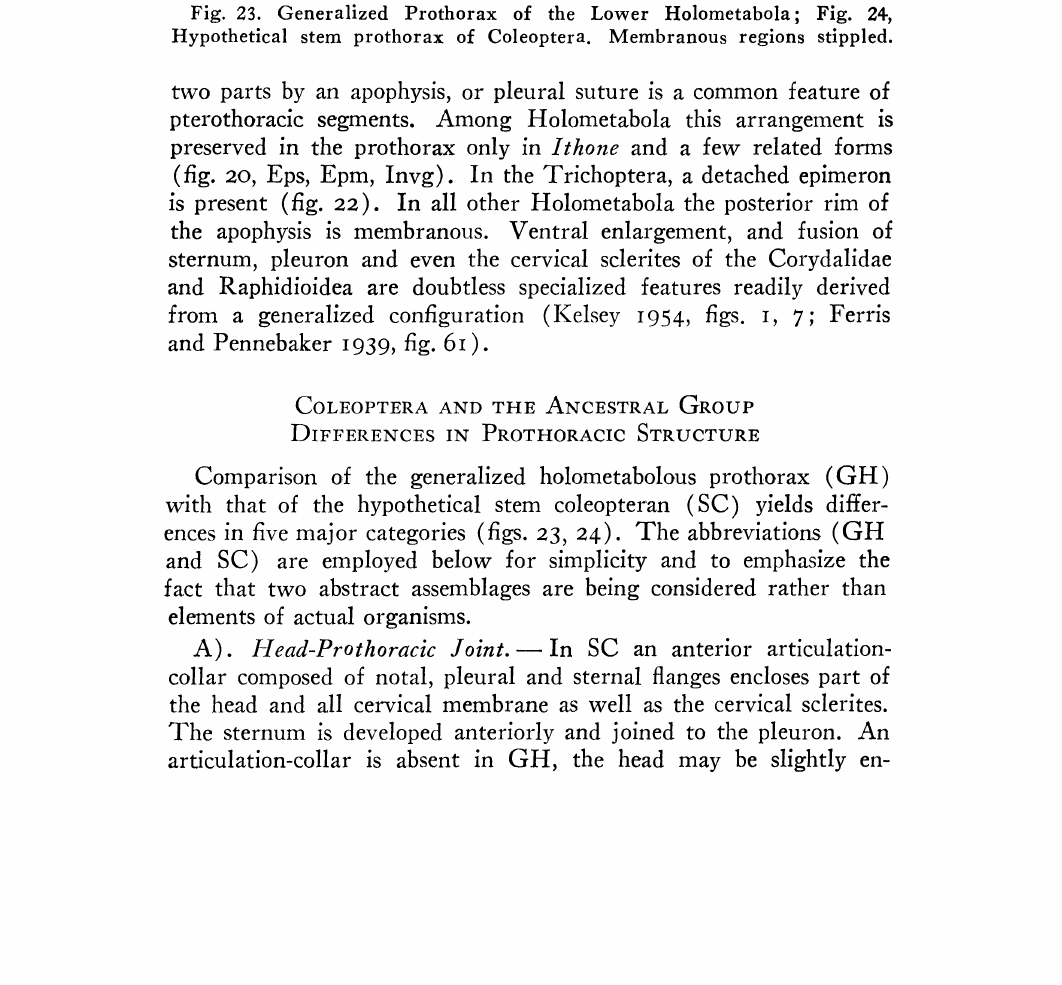
Fig. 23. Generalized Prothorax of the Lower Holometabola; Fig. 24, Hypothetical stem prothorax of Coleoptera. Membranous regions stippled. two parts by an apophysis, or pleural suture is a common feature